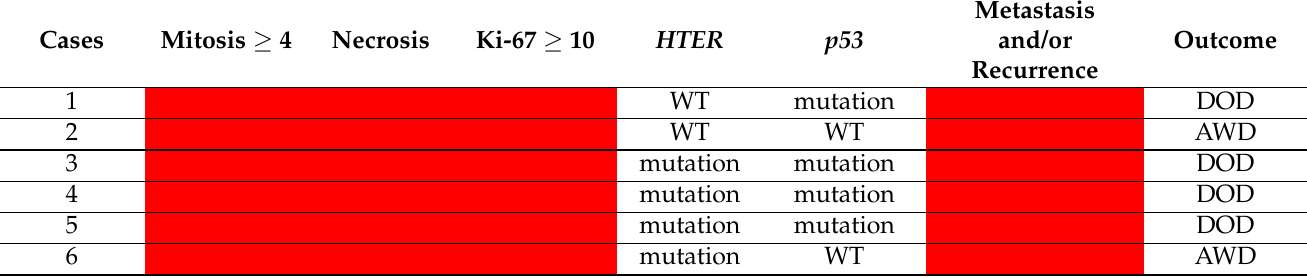
Table 7. High-risk solitary fibrous tumor (N = 6).